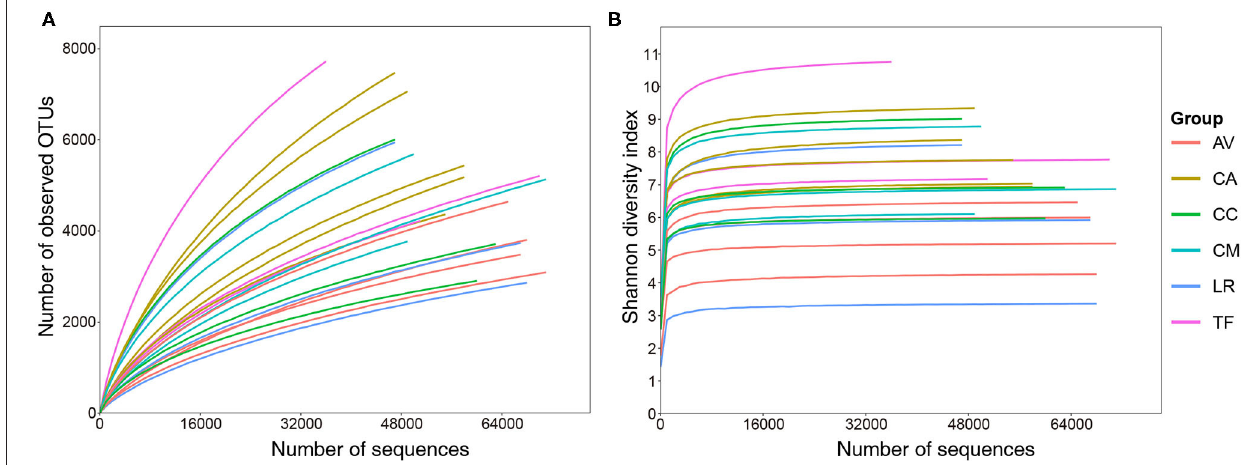
FIGURE 1 | Rarefaction (A) and Shannon–Wiener diversity (B) curves of bacterial populations in the analyzed samples. AV, demoiselle crane ( Anthropoides virgo ); CA, black swan ( Cygnus atratus ); CC, whooper swan ( Cygnus cygnus ); CM, Muscovy duck ( Cairna moschata ); LR, relict gull ( Larus relictus ); TF, ruddy shelduck ( Tadorna ferruginea